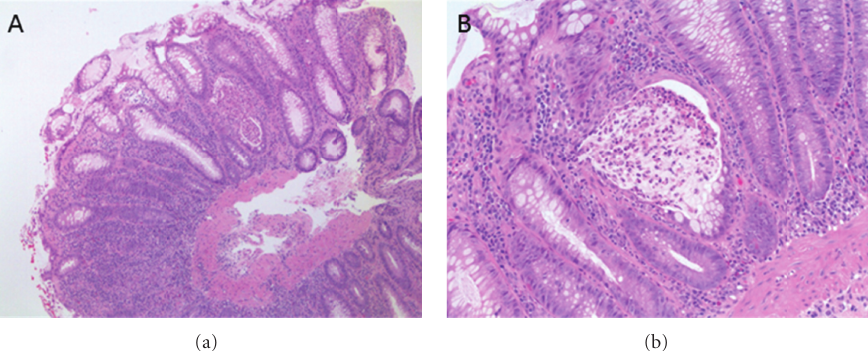
Figure 2: (a) A di ff use inflammatory cell infiltrate is present in the lamina propria with cryptitis (H&E; × 40). (b) A crypt is distended by mucus and neutrophils while the lining colonocytes are focally attenuated (H&E; × 100).